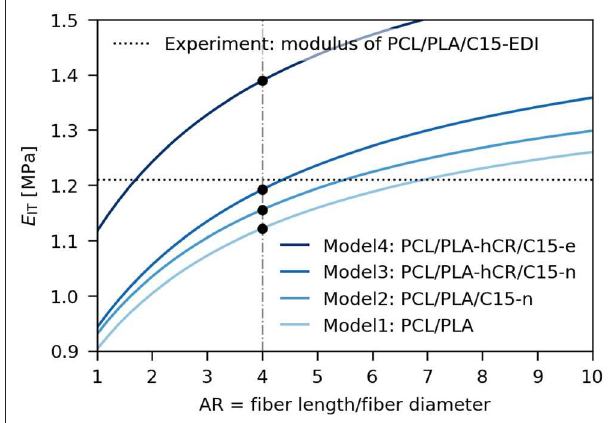
FIGURE 9 | Comparison of experimental elastic modulus of the final MFC composite, PCL/PLA/C15-EDI (dotted line), with theoretical predictions (full lines). Aspect ratio of PLA fibers (AR = 4) was estimated from SEM micrographs (dash-and-dot line). The first model (Model1: PCL/PLA) assumes just short oriented PLA fibers in PCL matrix. The second model (Model2: PCL/PLA/C15-n) adds correction for non-dispersed/isometric filler C15. The third model (Model3: PCL/PLA-hCR/C15-n) adds correction for increased modulus of PLA fibers due to their higher crystallinity. The fourth model (Model4: PCL/PLA-hCR/C15-e) is like Model3, but assumes fully dispersed C15 nanoplatelets with random